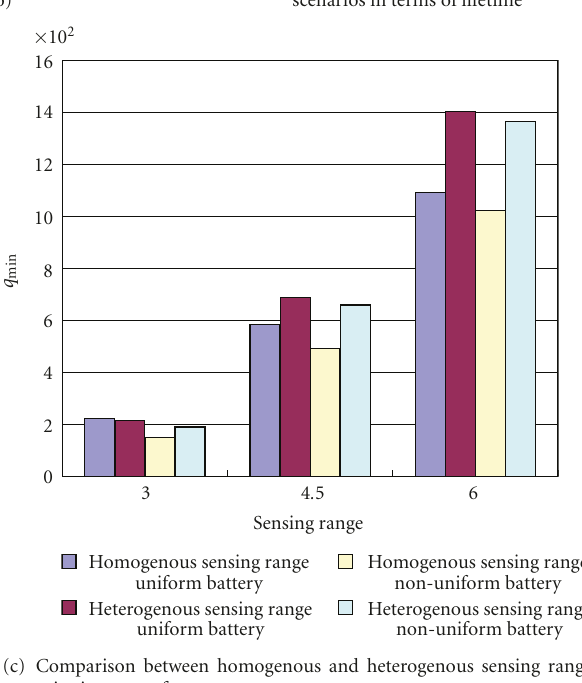
Figure 14: Comparison between homogenous and heterogenous sensing range